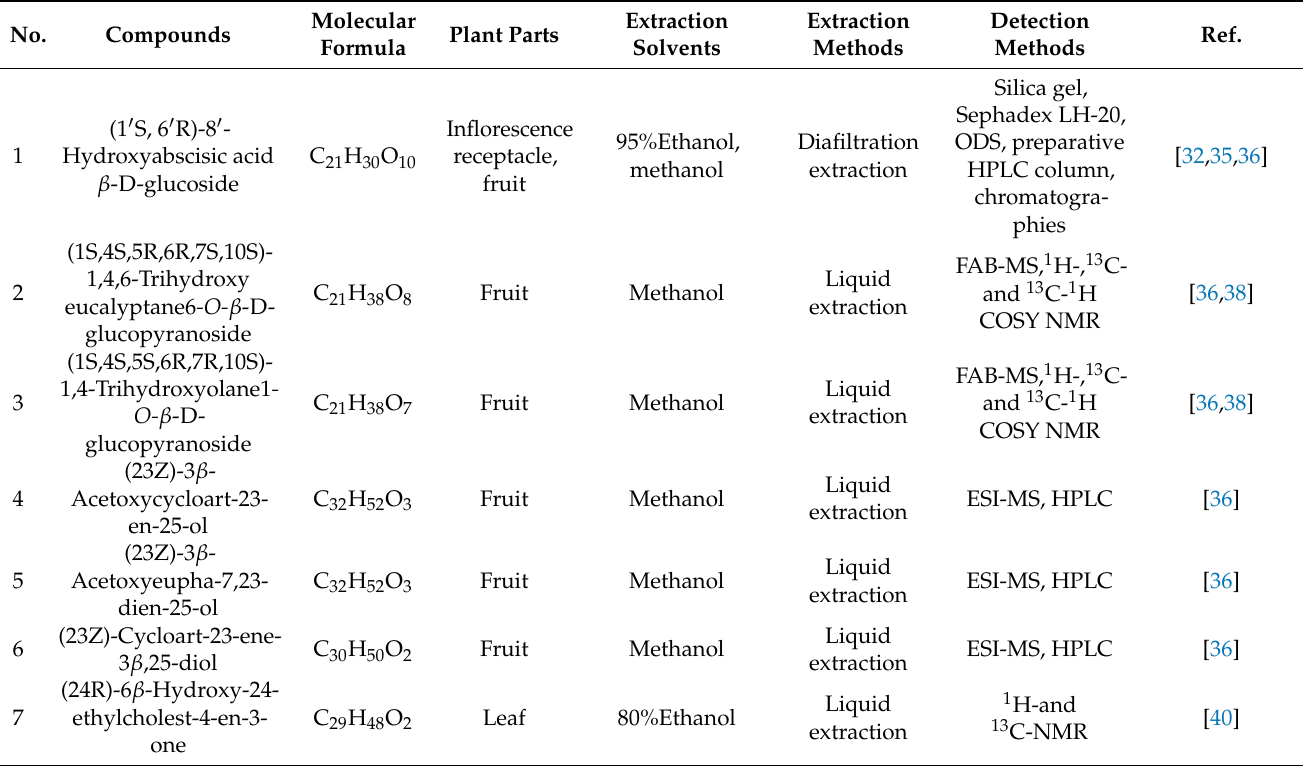
Table 3. Terpenoids found in Ficus pumila